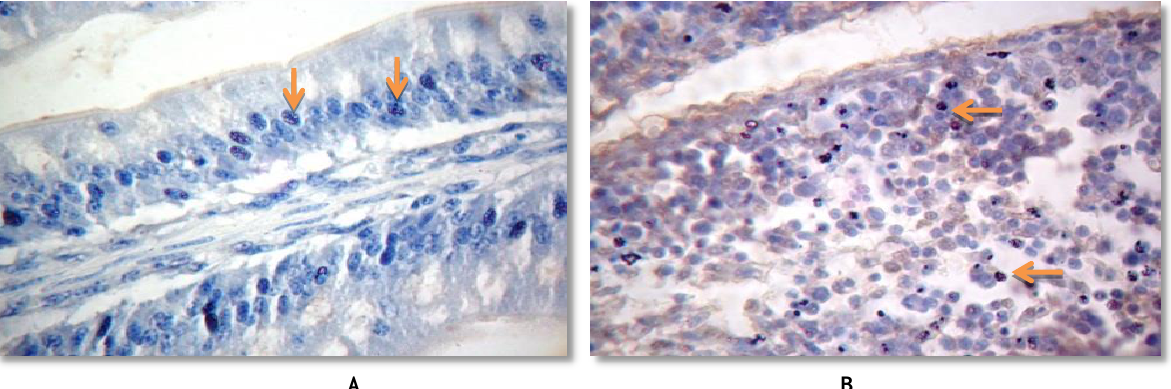
Figure ,7: Macrophages in paraffin embedded sections (5µm) were identified by using an anti-chicken monocyte-macrophage mouse monoclonal antibody (KUL01) and a HRP –conjugated secondary antibody A: Macrophages in the duodenum of non heat stressed treated with β -glucan 24 days old chick G3. Immunopositive cells are purple-brown ( ). B:Macrophages in the bursa of fabricius of non heat stressed treated with β - glucan 24 days old chick G3. Immunopositive cells are red-brown. ( ) 100